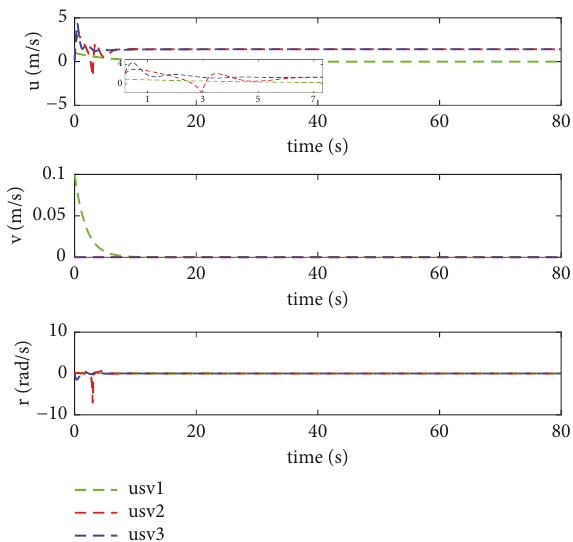
Figure 4: The force and torque of USV 2 and USV 3.